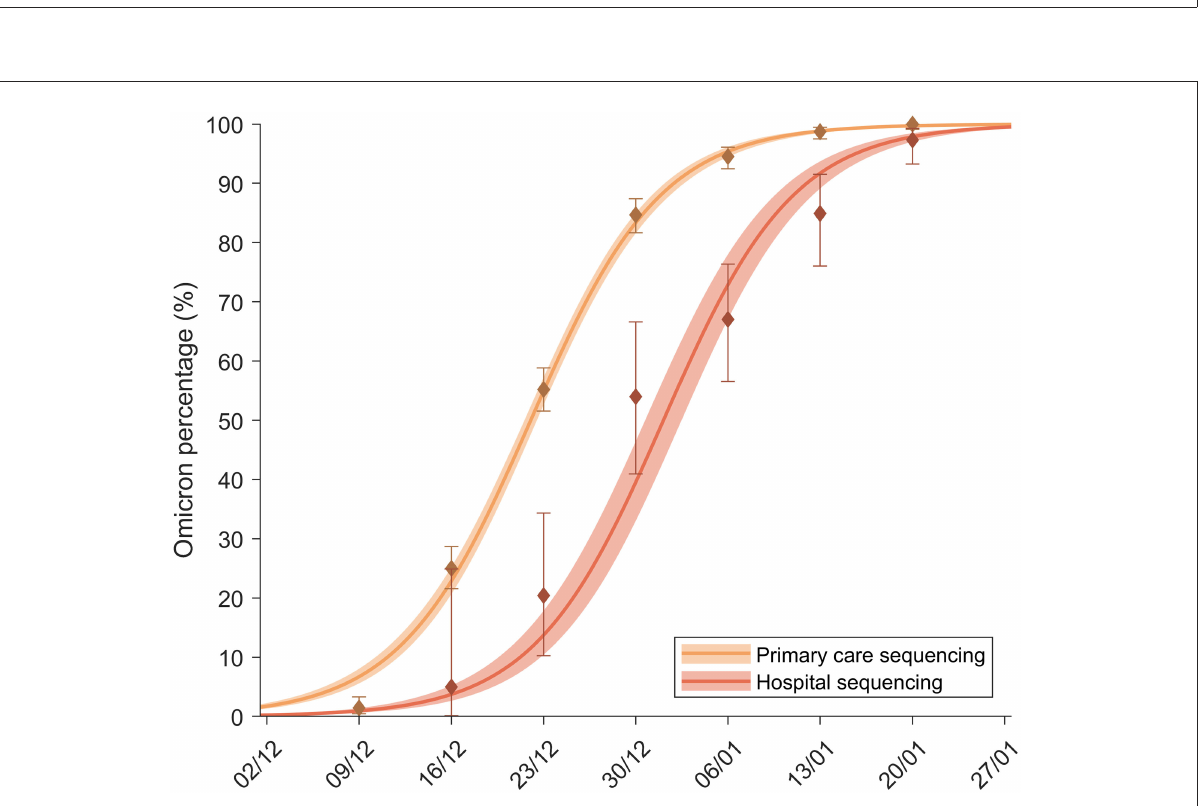
FIGURE3 Percentage of omicron among screened samples of primary care patients (yellow) and hospital patients (orange). The continuous lines show the substitution model fitted to each